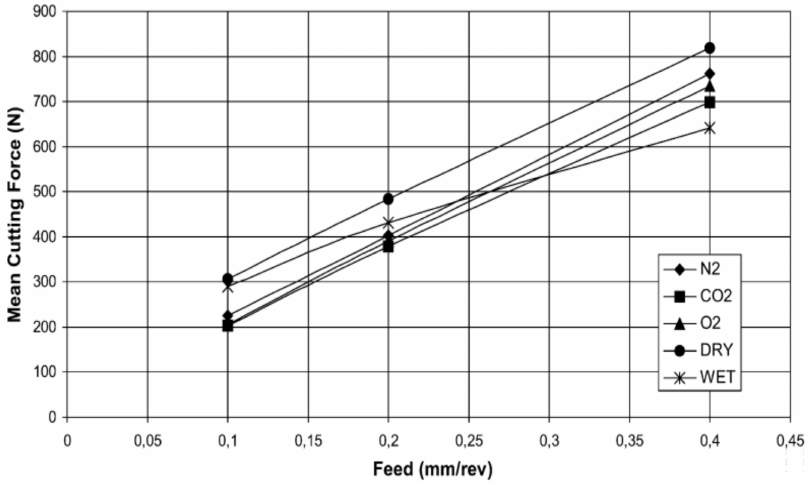
Figure 33. Variation in cutting force by using different machining techniques, reprinted with permis- sion from ref. [179]. Copyright 2004 Elsevier